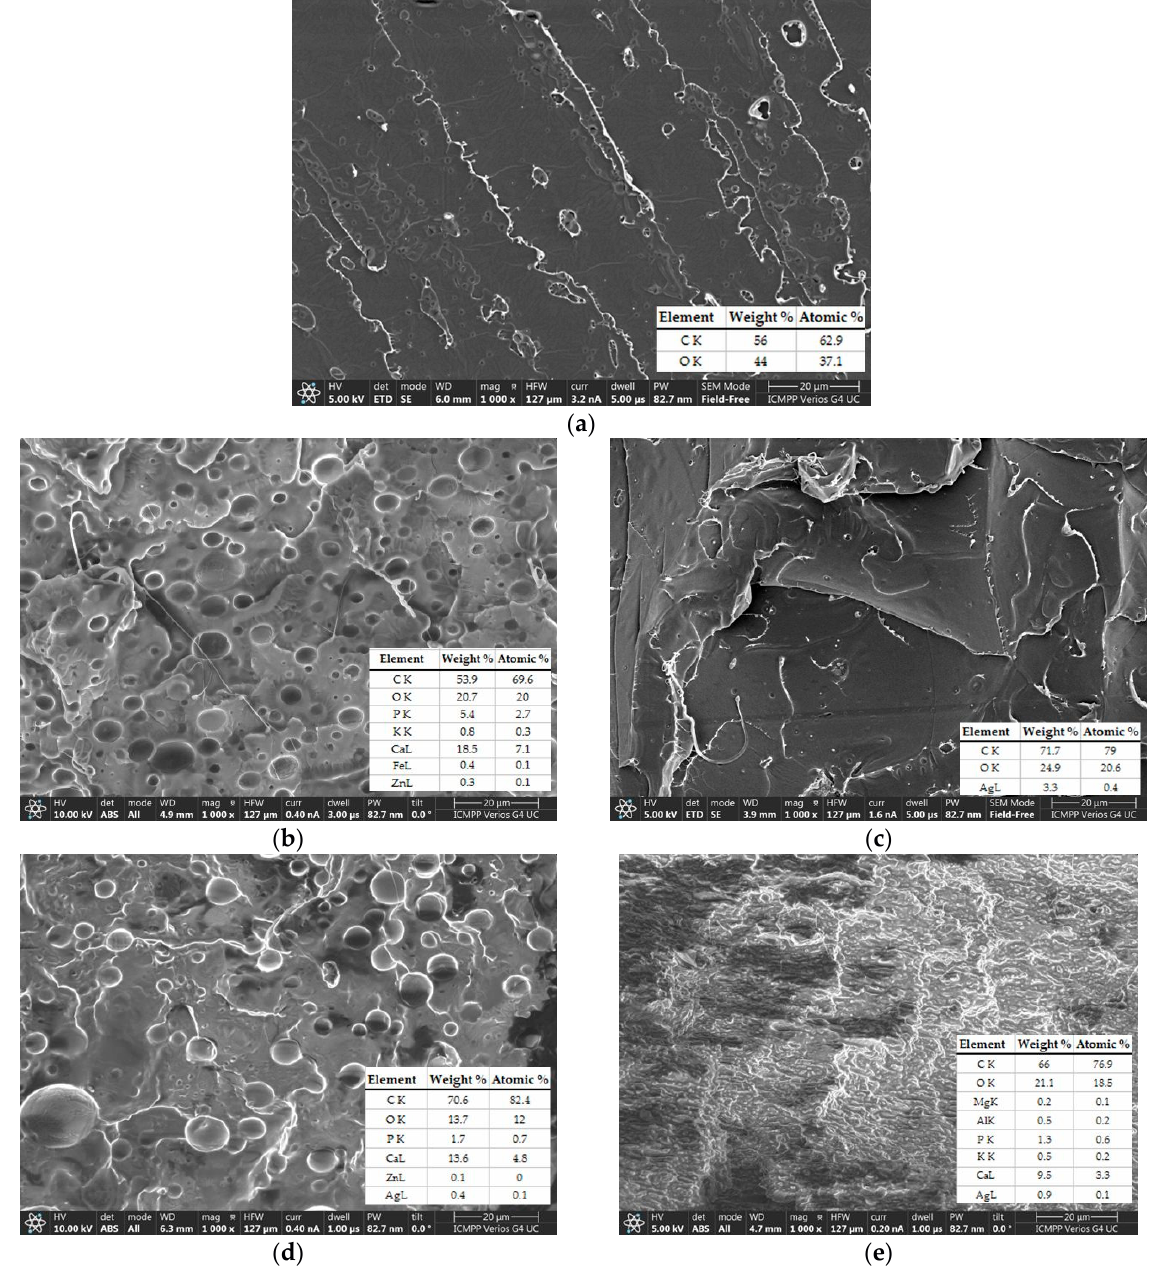
Figure 3. Morphology with elemental composition for the PLA-based biocomposites. Neat PLA ( a ), PLA/CO ( b ), PLA/S ( c ), PLA/CO/S ( d ), and PLA/CO/S/I.31PS ( e